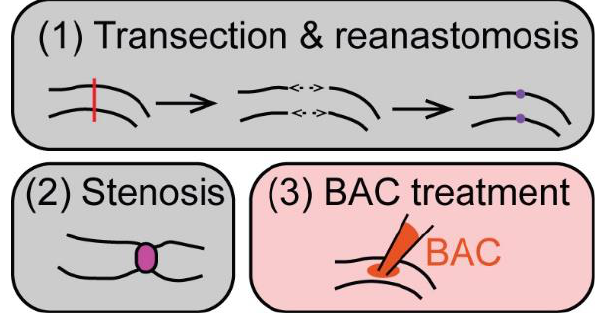
Figure 2. Common ENS injury approaches in mammals. Common models using surgical (grey boxes) or chemically induced (red) injury methods to study ENS regeneration in mammals: ( 1 ) transection and reanastomosis: the targeted part of the gut is transected (red line) with subsequent end-to-end anastomosis (purple). ( 2 ) For stenosis, a ring (magenta) is placed around the gut, which causes partial obstruction. ( 3 ) Benzalkonium chloride (BAC) treatment comprises the treatment of a small gut segment with BAC, which leads to a loss of ENS neurons in the treated